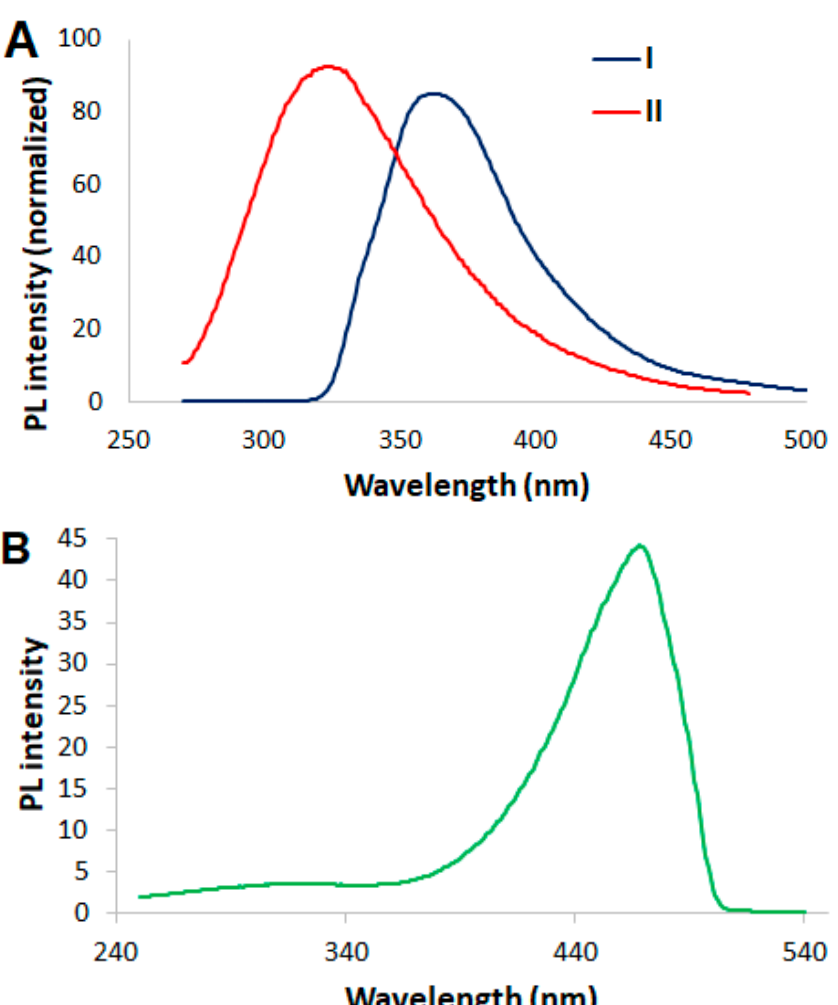
Figure 3. ( A ) The absorbance spectrum of 7 (10 μ M) (I) and the emission spectrum of 6 (10 μ M) (II). ( B ) The emission spectrum of the probe 5 (10 μ M) in HEPES buffer (pH